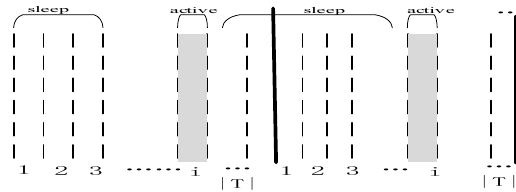
Figure 3. Example of periodical wake up of node v .